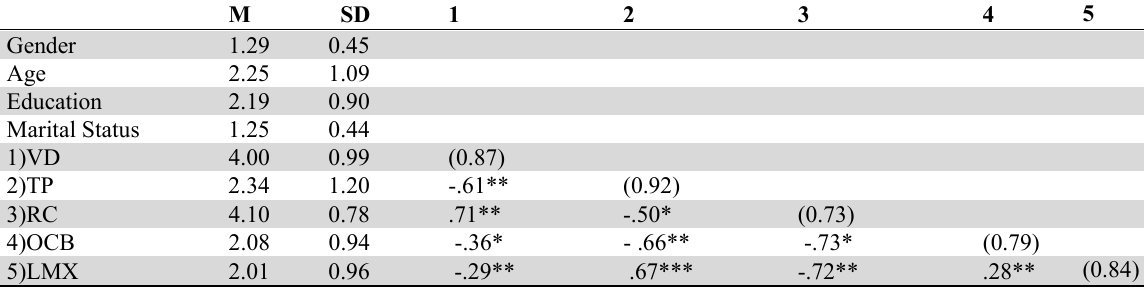
Mean, S.D, Correlation, and reliability analysis of study variable